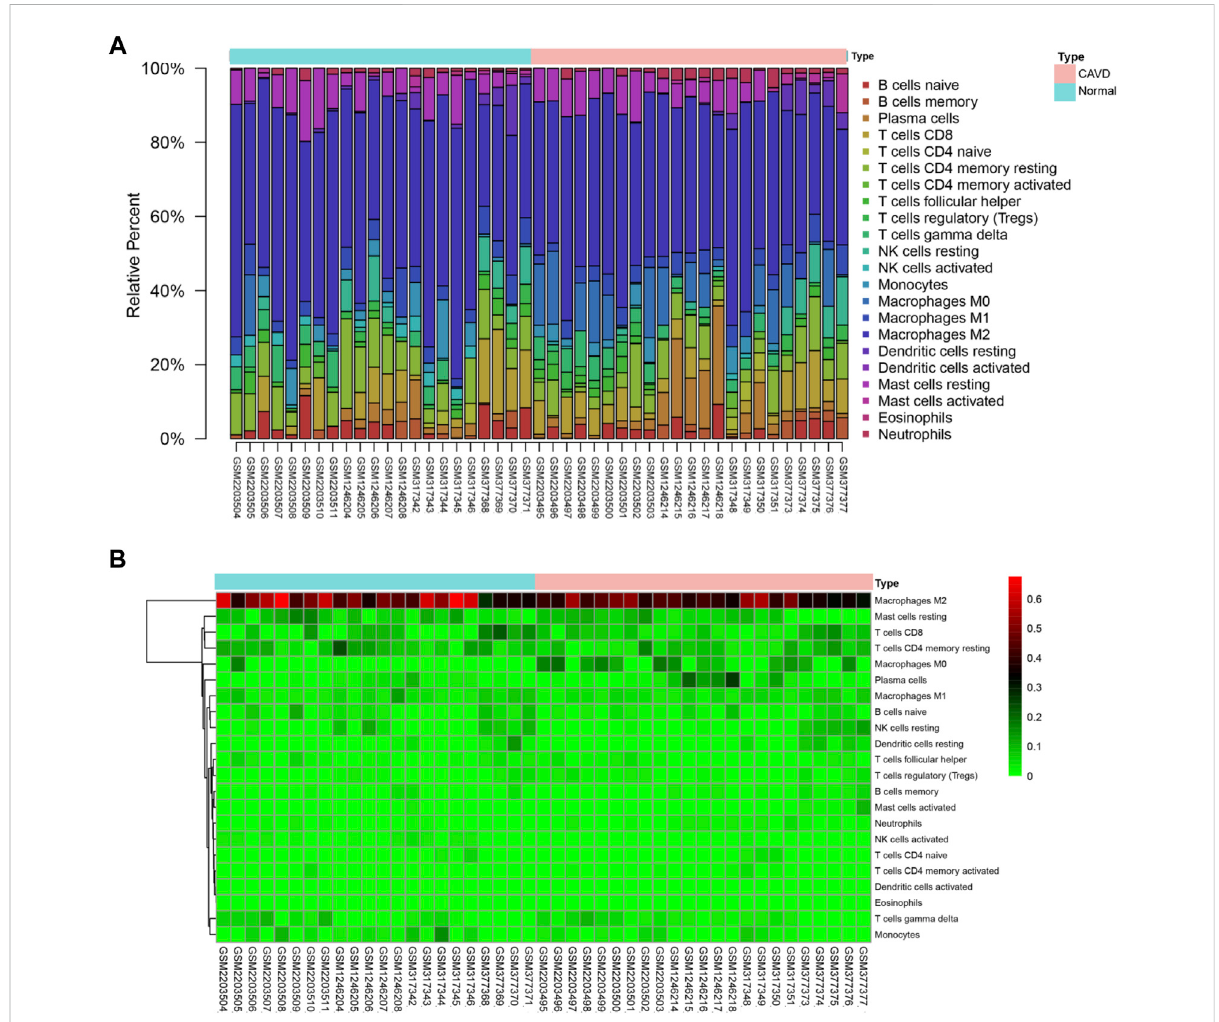
FIGURE 3 Summaryofimmunecellsin fi ltrationincalci fi edandnormalaorticvalvesamples. (A) Barplotshowstherelativefractionsof22typesofimmune cells in each sample. (B) Heatmap of the relative fractions of 22 subpopulations of in fi ltrating immune cells in each sample, green to red indicates an increase in relative fractions of immune cells in fi ltration. CAVD, calci fi c aortic valve